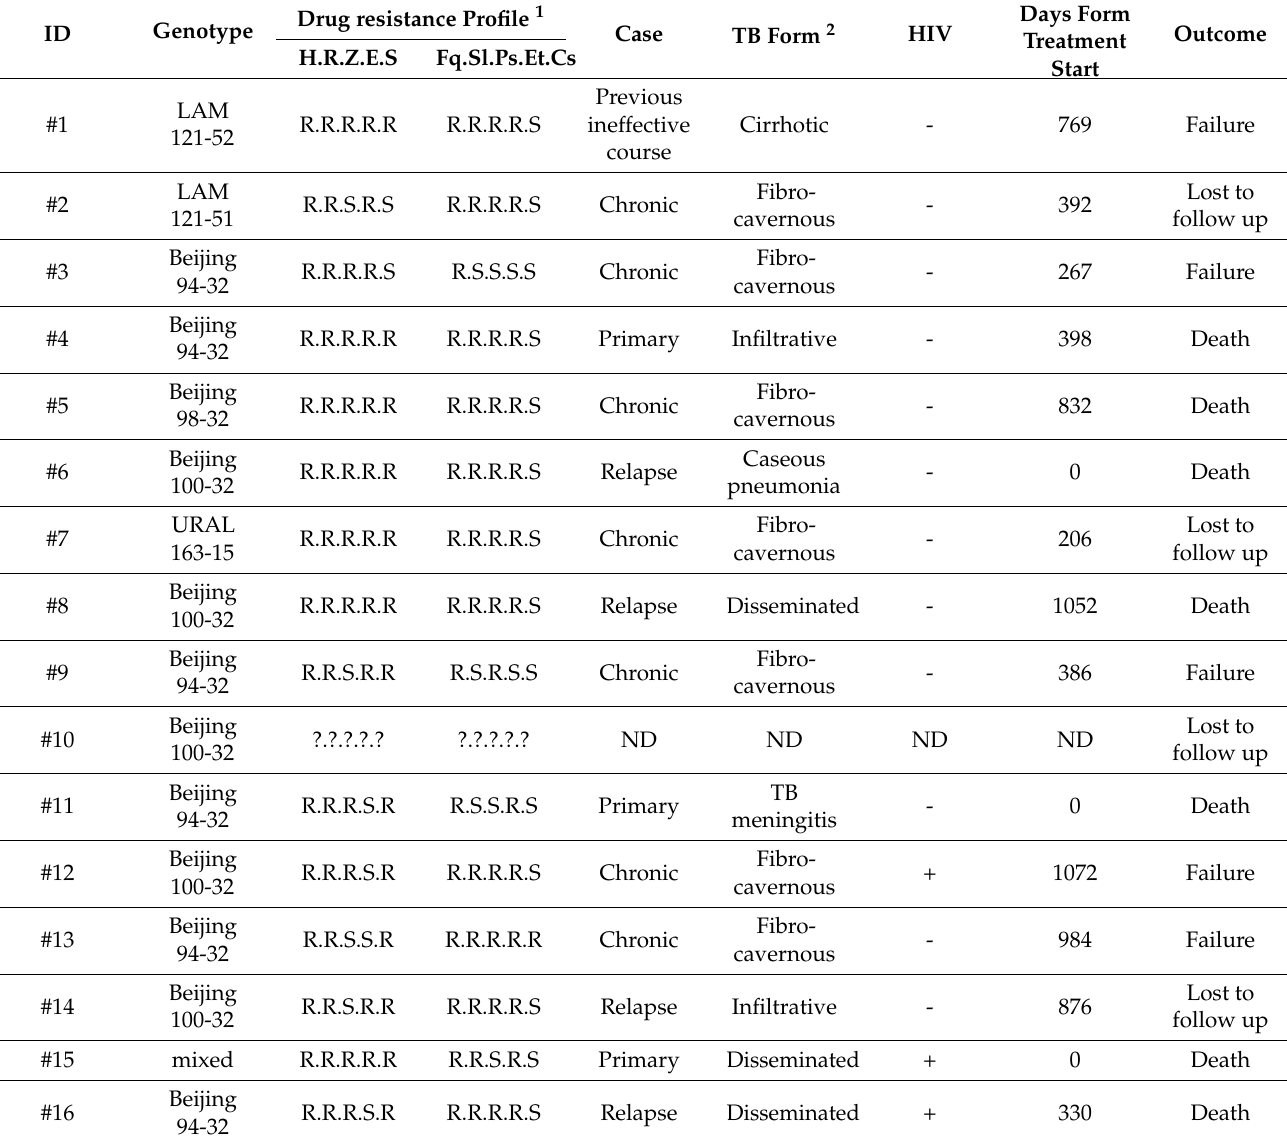
Table 2. Resistance profiles of the isolates and clinical characteristics of the